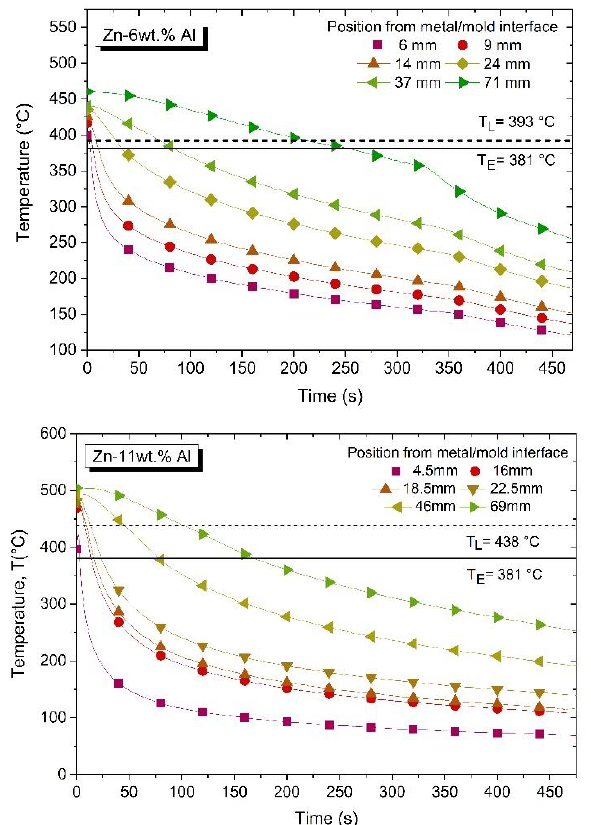
Figure 4. Cooling profiles along the length of the DS Zn-6wt.%Al and Zn-11wt.%Al alloys castings. The cooling rate profiles related to the liquidus, and the eutectic isotherms are shown in Figure 6. A power function of the form ˙T = cP − d , being c and d constants, is fitted to the experimental points along the length of each alloy casting. The cooling rate profiles of both Zn-6wt.%Al and Zn-11wt.%Al alloys castings show that at positions close to the cooled bottom of the castings the solidification process occurs at high cooling rates.